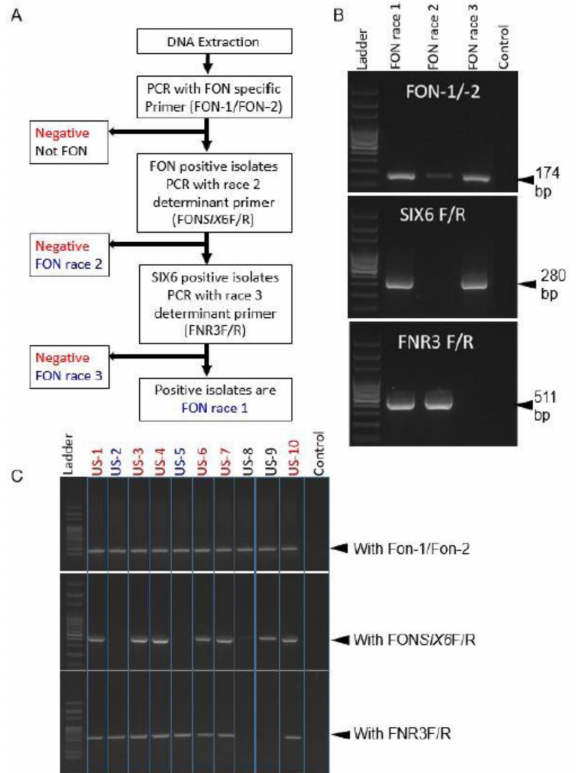
Figure 3. Flow diagram of three marker sets distinguishing Fon races 1, 2, and 3 ( A ); Example of dif- ferentiation of known Fon races ( B ); Identification of unknown Fon races 1, 2, and 3 ( C ). Source: